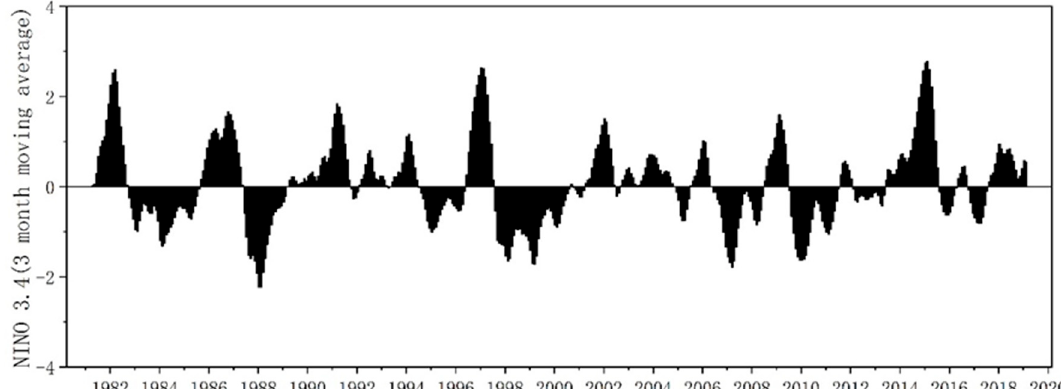
Figure 2. Distribution of the Niño 3.4 index (three-month moving average) from 1980 to 2020. ENSO events are mainly identified by the three-month moving average absolute value of Niño 3.4. The three-month moving average of Niño 3.4 index was derived from the National Climate Center of China Meteorological Administration (https://cmdp.ncc-cma. net/pred/cn_enso.php?product=cn_enso_nino_indices (accessed on 11 January